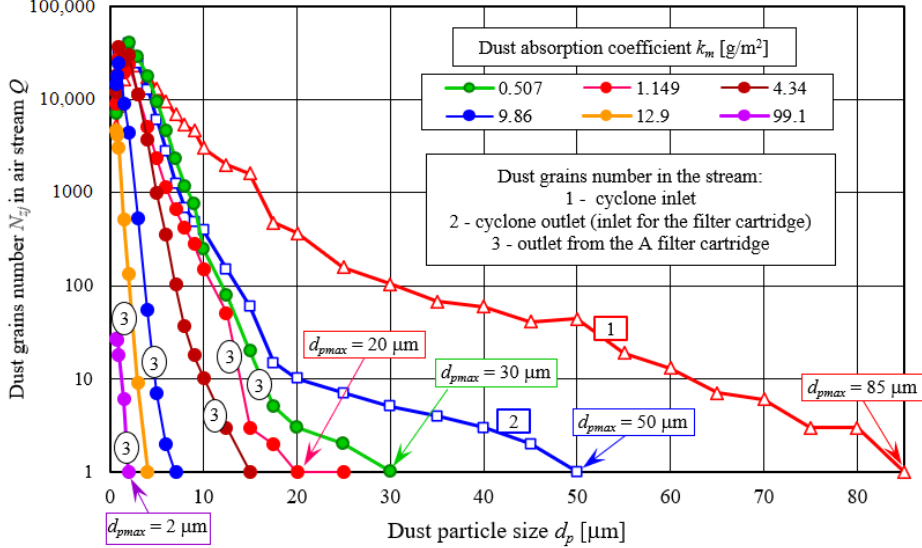
Figure 10. Dust grains number in inlet stream to the cyclone (1), outlet stream from the cyclone (2), and outlet stream from the filter element (3) in individual size ranges for different values of dust absorption coefficient ( k m ) during filter element A tests (cellulose) in set operation “cyclone–cartridge”.